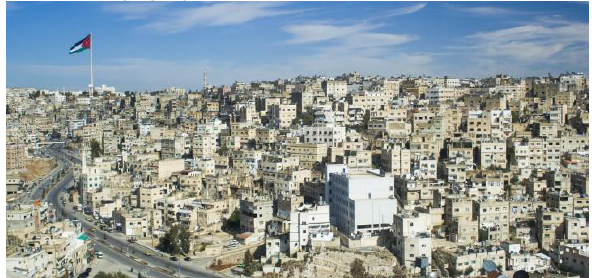
Figure 2. Homogenized Building Create an Ugly City and Lack of Sense of Place for Users (URL 1).